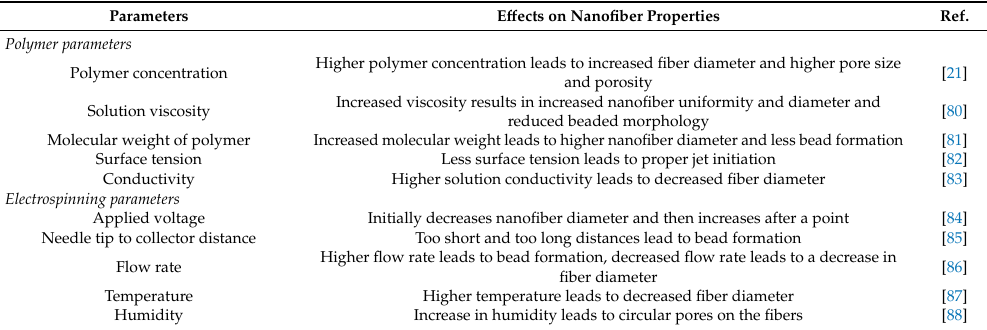
Table 3. The e ff ects of electrospinning parameters on